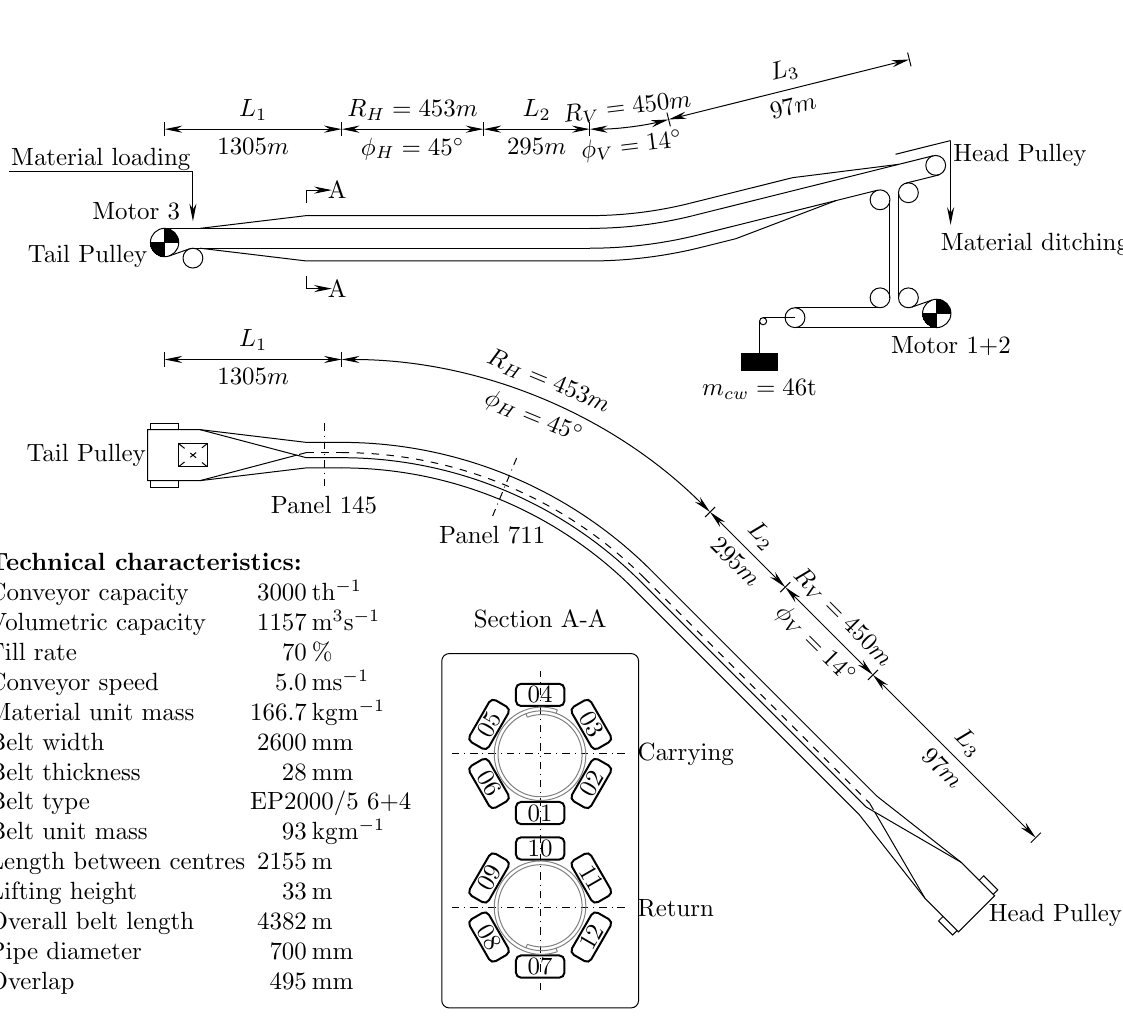
Figure 1: Pipe system in sectional and plan view, including technical characteristics.